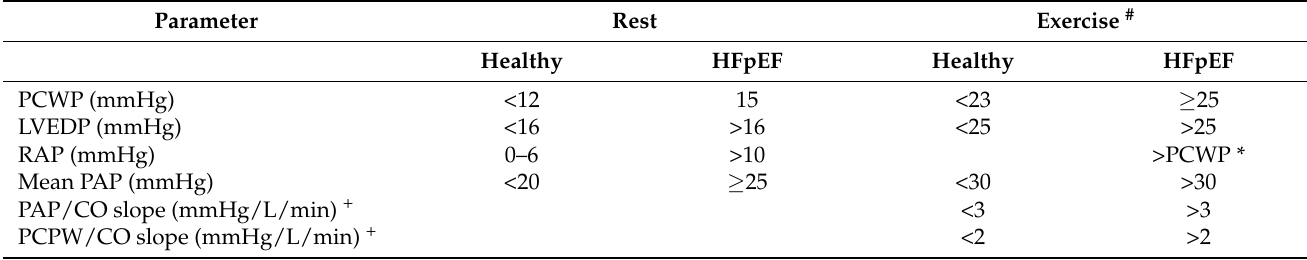
Table 4. Cut-off for main parameters in heart right catheterization for HFpEF